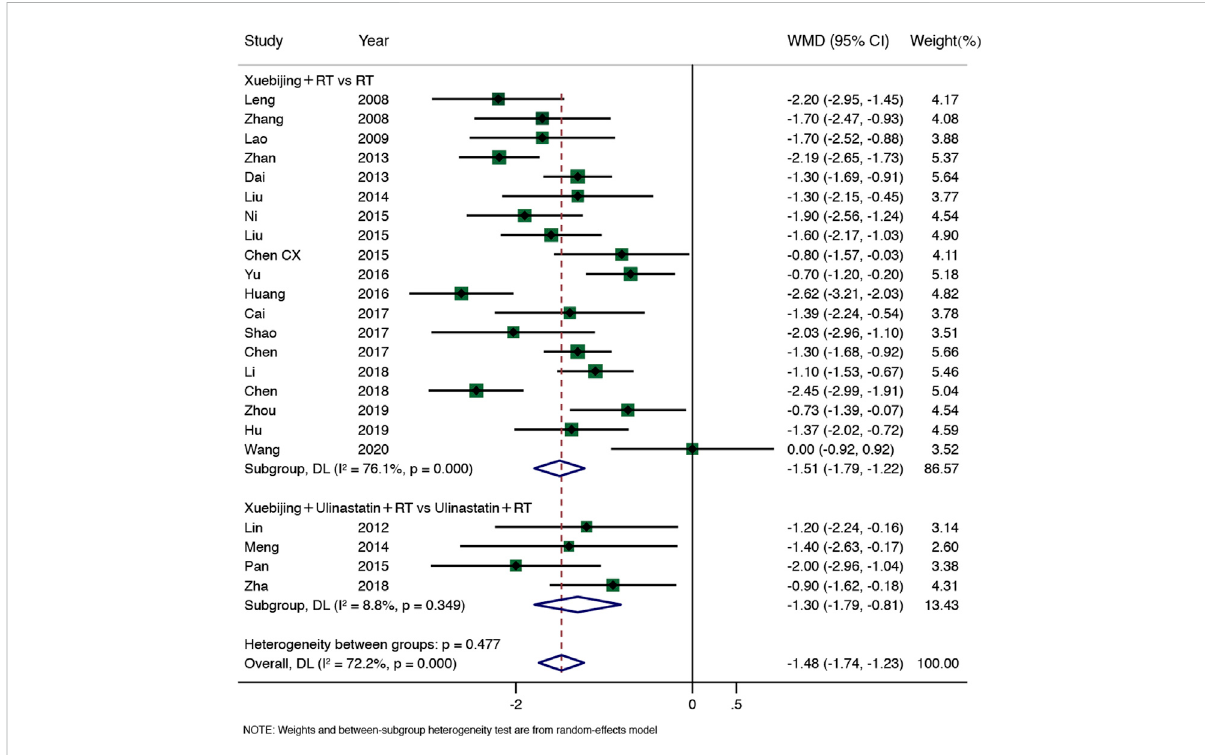
FIGURE 5 Meta-analysis of time until relief of abdominal